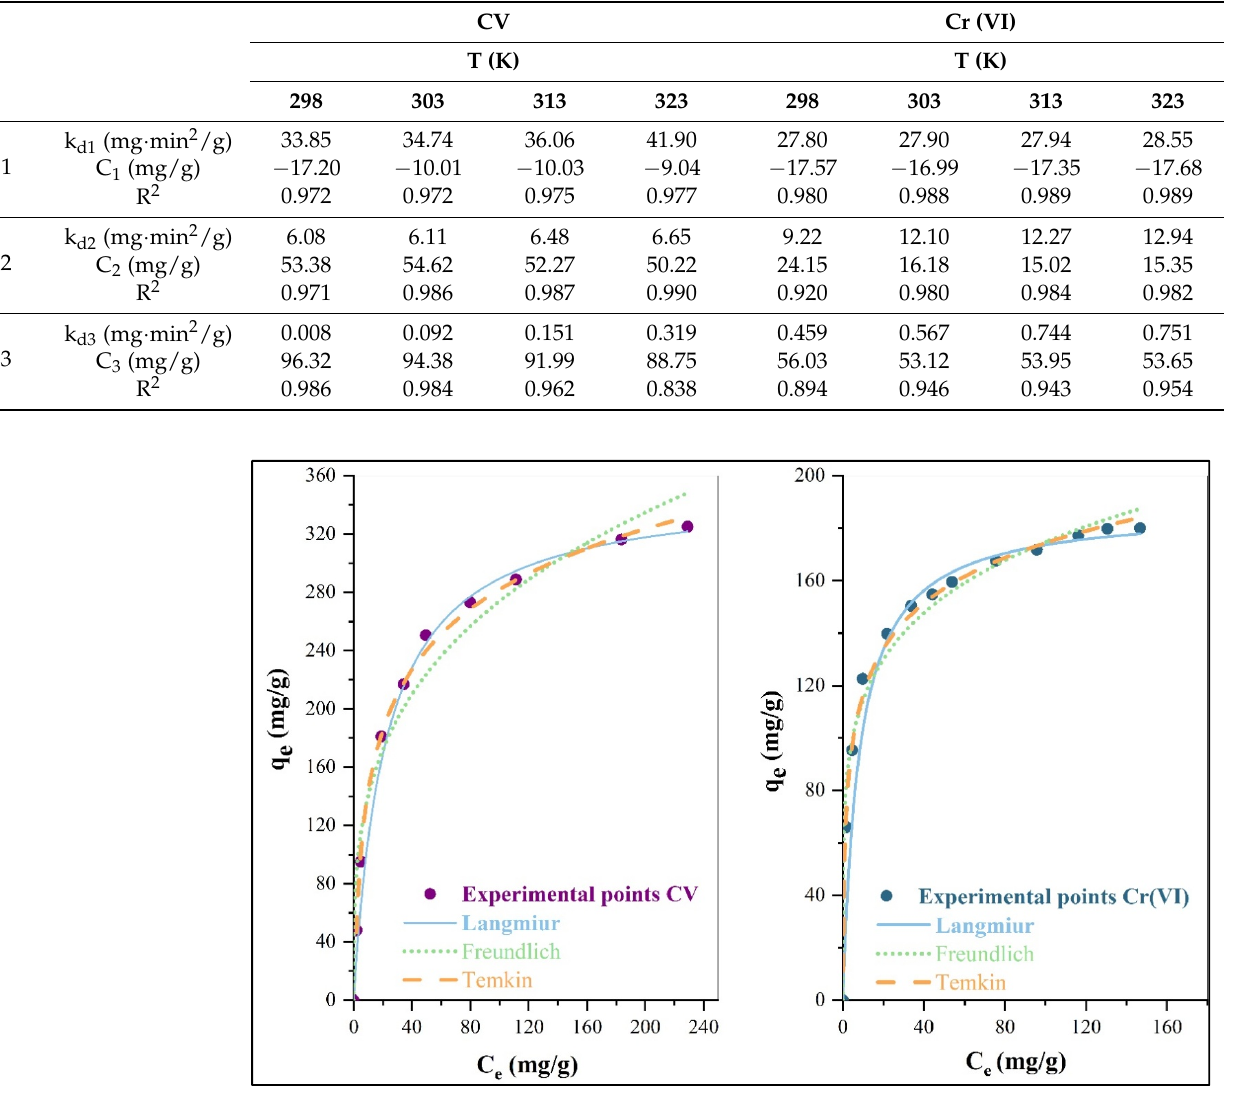
Figure 13. Adsorption isotherm curves for CV and Cr (VI) at 30 °C. Table 6. Adsorption isotherm constants for CV and Cr (VI) at 30 °C.